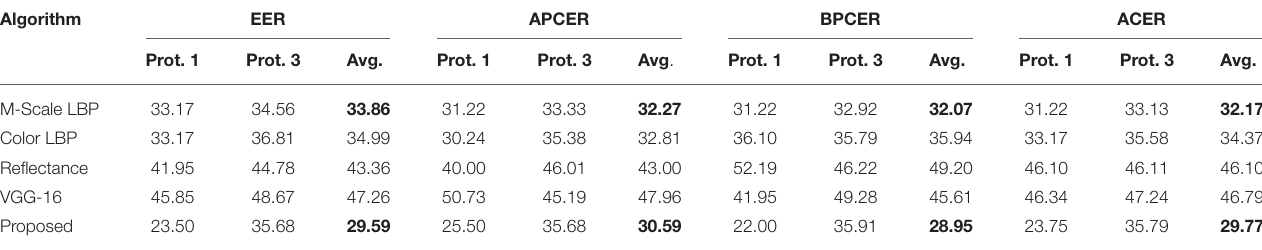
TABLE 9 | Wax figure face detection error rates (%) on the unconstrained (protocol 1) and real-world protocol (protocol 3) of WFFD database (Jia et al., 2019).